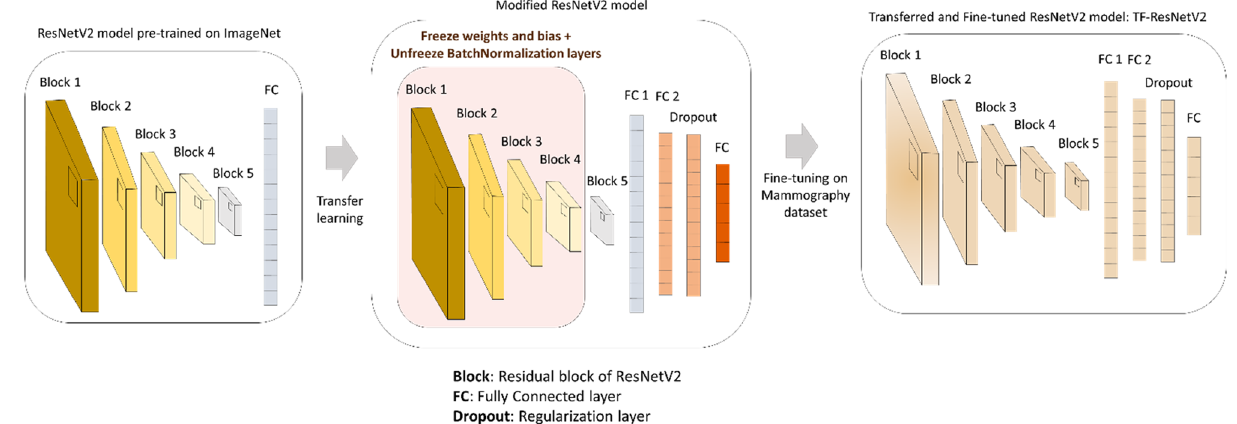
Figure 1. Framework of the classification base model: a TF-ResNetV2 model which is a ResNetV2 model pre- trained on ImageNet data and modified and fine-tuned on mammography